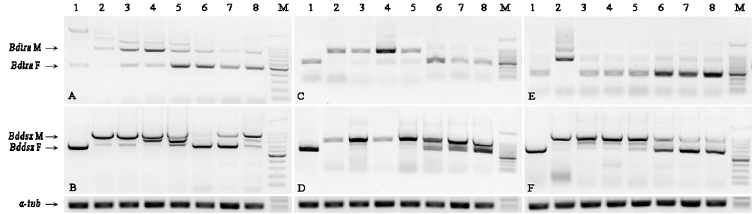
Fig 4. Expression patterns of Bdtra and Bddsx in RNAi males. (A, B) Injection with ds Bdtra _79. (C, D) Injection with ds Bdtra _613. (E, F) Injection with ds Bdtra-2 _422. (A, C, E) Detection of the transcripts of Bdtra . (B, D, F) Detection of the transcripts of Bddsx . Abbreviations and notes: Bdtra M and Bddsx M: male-specific splicing forms of Bdtra and Bddsx respectively; Bdtra F and Bddsx F: female-specific splicing forms of